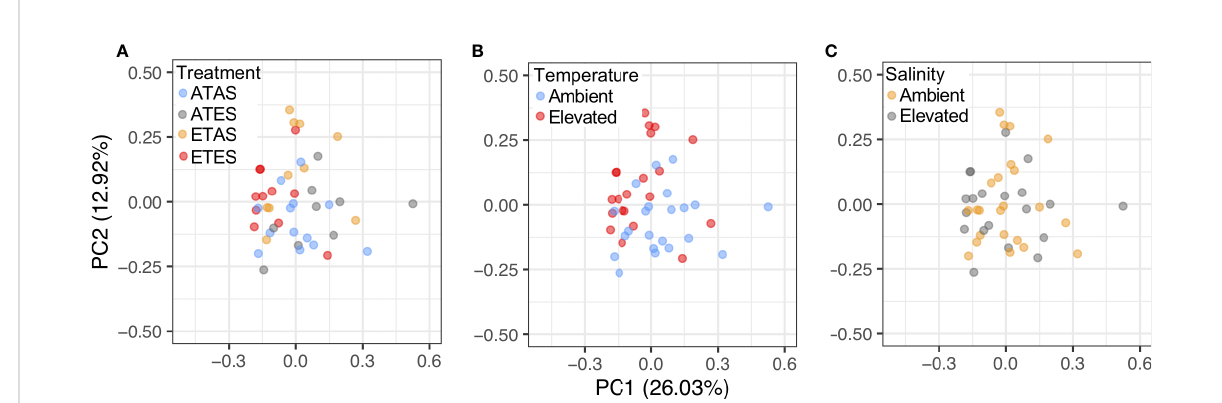
FIGURE 3 Principal components analysis biplots showing the similarity in composition of non-volatile compounds in blue swimmer crab ( Portunus armatus ) meat following experimentation (A) among all treatments, and between levels within the (B) temperature, and (C) salinity treatments. ATAS, ambient temperature and salinity; ATES, ambient temperature and elevated salinity; ETAS, elevated temperature and ambient salinity; and ETES, elevated temperature and